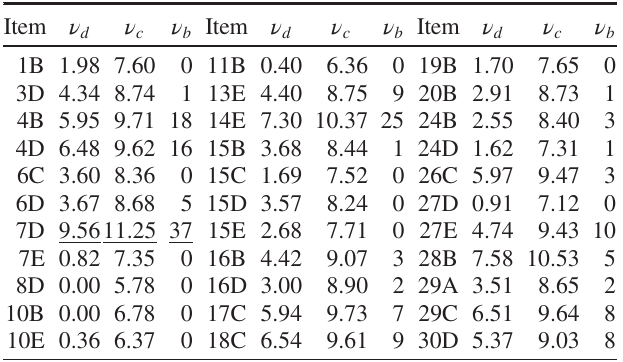
TABLE IV. Degree, closeness, and betweenness centrality measures for factor 2 items. The values of ν by a constant factor of 10 3